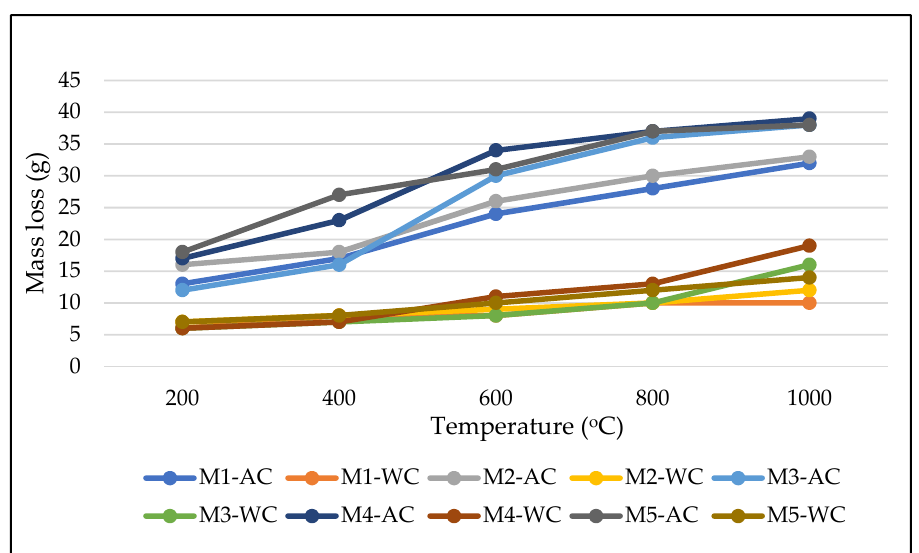
Figure 5. Mass loss of full-water-cured samples at elevated temperatures (where AC is air cooling, and WC is water cooling).